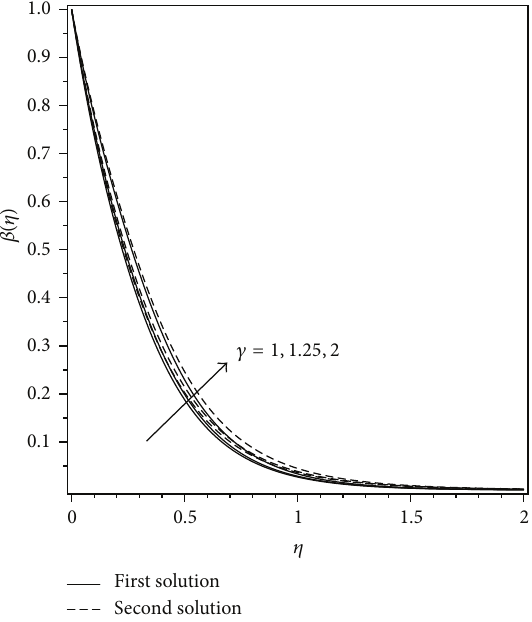
Figure 10: Concentration profiles for different values of 𝛾 when Nb = Nt = 0.5, Le = 2, Pr = 6.8, 𝜎 = − 0.1, and S = 2.